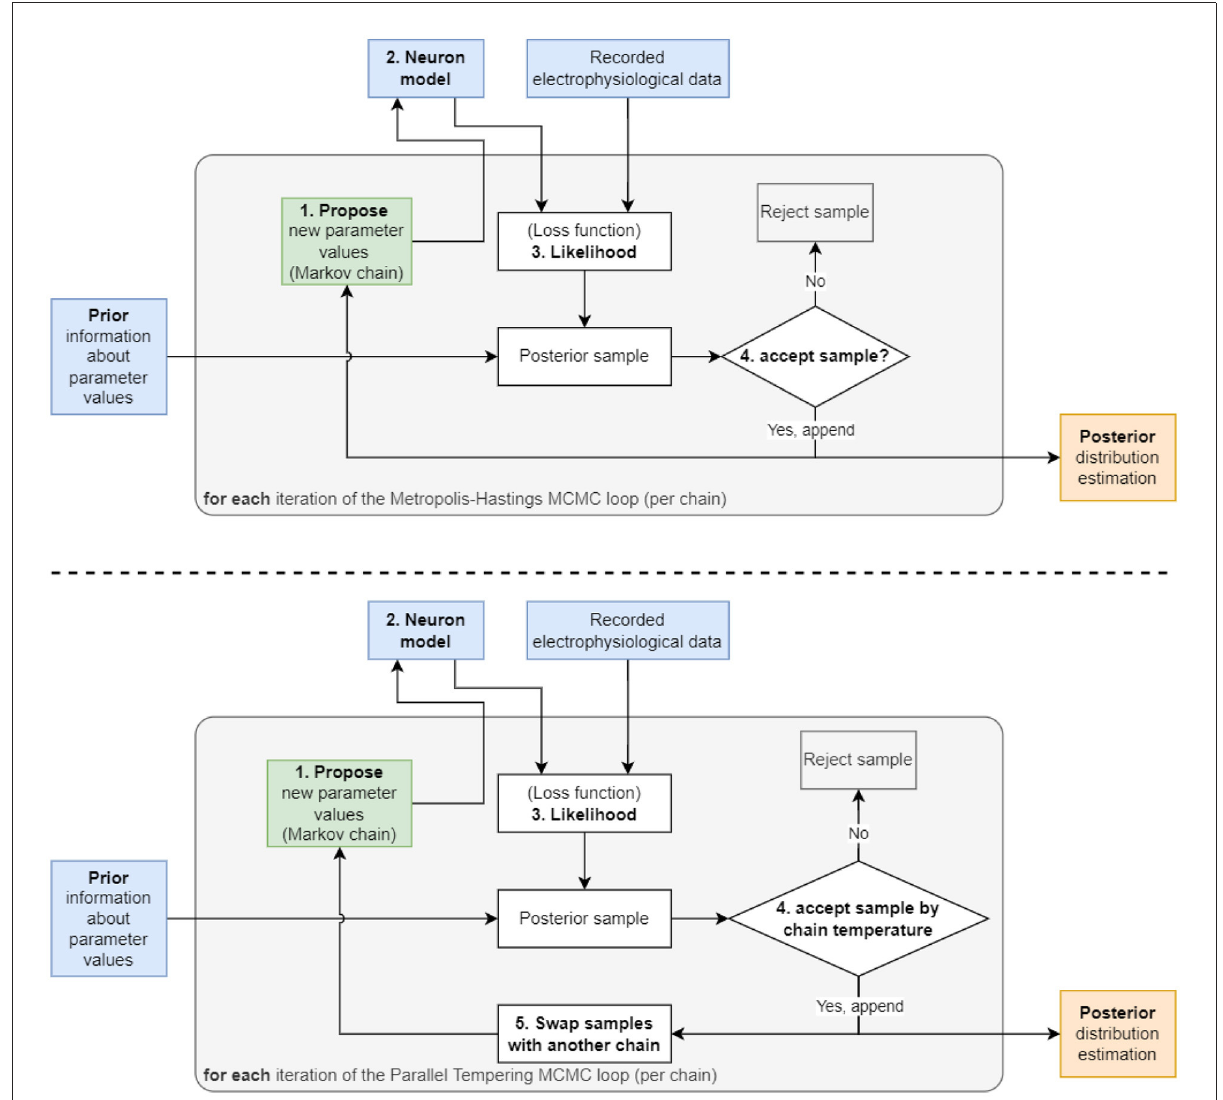
FIGURE1 Two diagrams depicting the flow of the two algorithms used in this work. (Top) The Metropolis–Hastings MCMC algorithm begins with a “1. Propose” step, where the algorithm selects an initial set of parameters to be used in the “2. Neuron model” step. The model is then solved using the parameters and its output compared to recorded data to produce the “3. Likelihood”. This likelihood is then multiplied with the prior to generate the probability value used in the “4. accept sample?” step to accept or reject the sample. This cycle is repeated until the number of preset iterations is reached. (Bottom) The Parallel Tempering MCMC algorithm used for the 9 parameter AM model. This algorithm utilizes an additional “5. Swap samples with another chain” step to increase mixing between multiple chains and to encourage the chains to sample in more remote areas of the parameter space, hence, detect